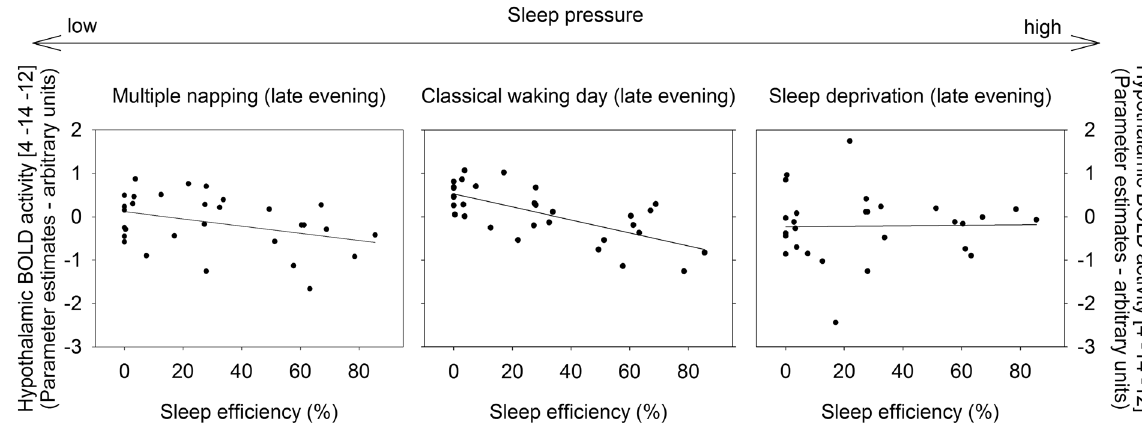
Figure 3. While hypothalamic blood-oxygen-level-dependent (BOLD) activity (depicted on the y-axis) was negatively associated with sleep efficiency (assessed in the late evening) after a classical waking day (middle panel), this relation was not significant during multiple napping (left panel; p = 0.05, not surviving correction for multiple comparisons) or sleep deprivation (right panel; p > 0.05). Multiple napping refers to conditions of low sleep pressure, as BOLD activity has been assessed after 2 h of continuous wakefulness. In comparison, the scan session after a night of sleep deprivation was scheduled at 37 hours of continuous wakefulness and thus took place under high sleep pressure